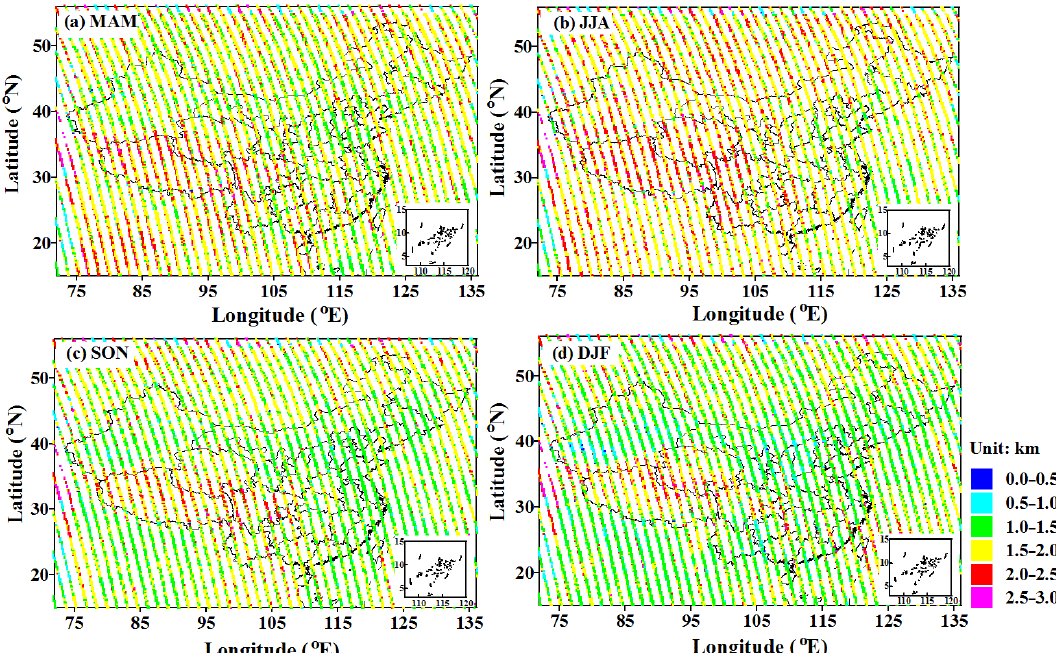
Figure 4. Spatial distributions of climatological PBLHs derived from CALIOP at 13:30BJT in (a) spring (March–April–May, MAM), (b) summer (June–July–August, JJA), (c) autumn (September–October–November, SON), and (d) winter (December–January–February, DJF) during the period 2011–2014. Horizontal resolution is resampled to 20km along the ground track.